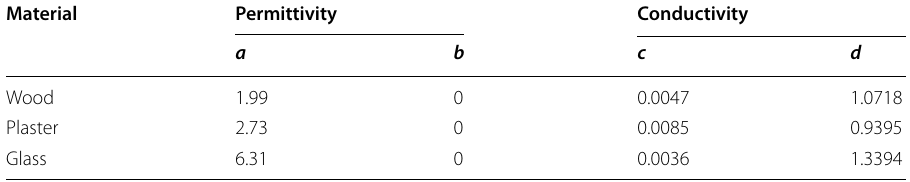
Table 1 Parameters of three common building materials recommended by ITU-R P.2040-2 Material